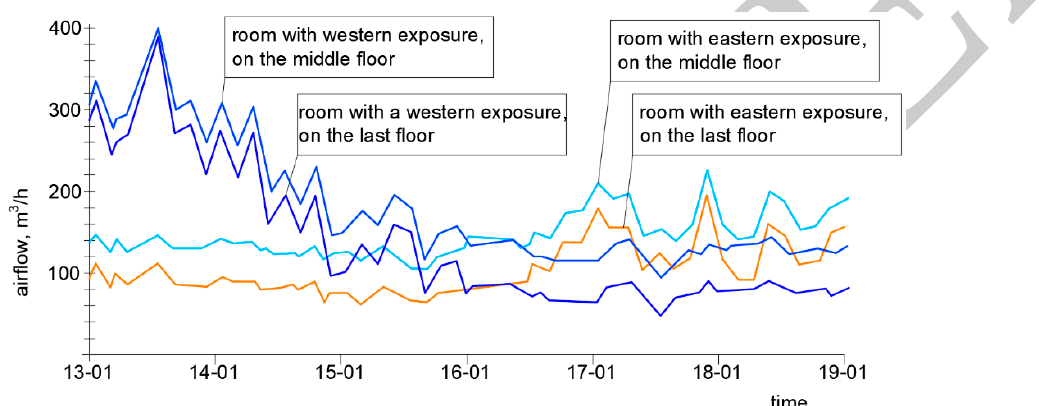
Figure 3. The course of variability of the air stream for a selected week of the heating season (variant A) for four example classrooms with different exposure.